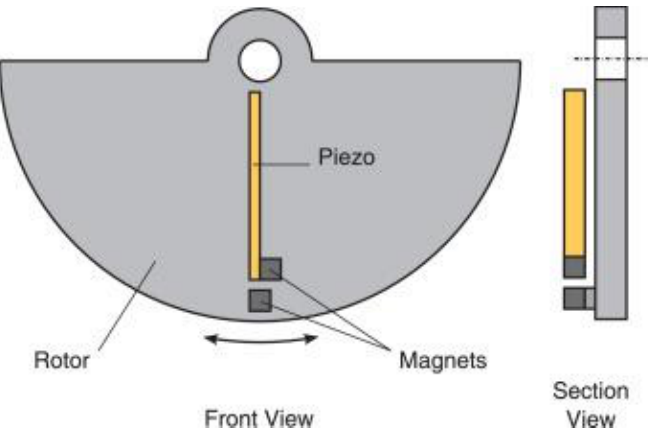
Figure 7. Principle of operation of the rotational beam-plucking energy harvester ([48] license number: